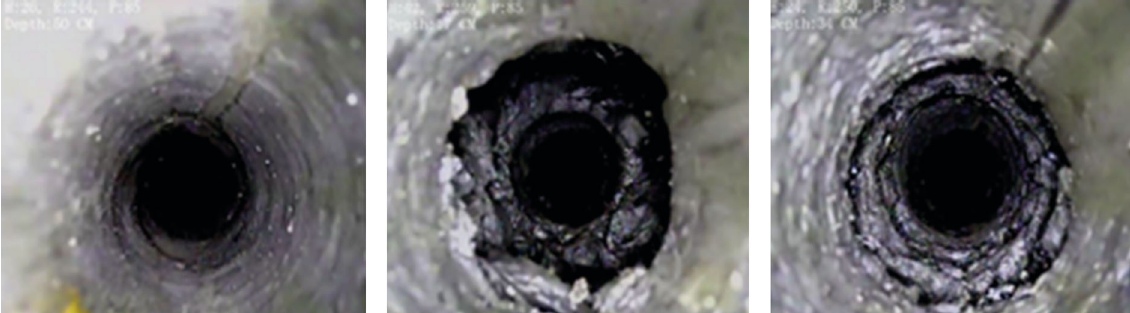
Figure 10: Distribution law of cracks in roof strata (3# drill hole). Table 1: Observation results of RBIT-30 borehole imager.